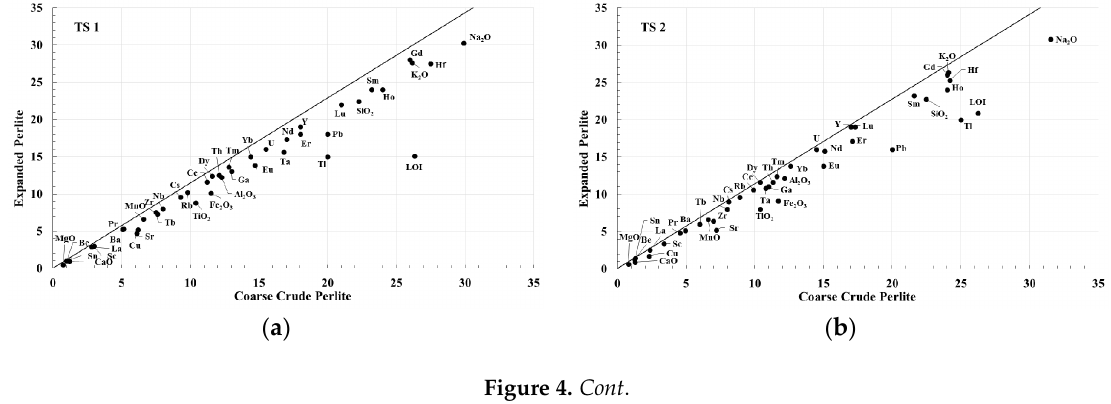
Table 2. Whole-rock chemical composition of crude 1.18–2.5 mm perlite samples from Tsigrado and Trachilas areas (-: below detection limit; LOI: loss on ignition).